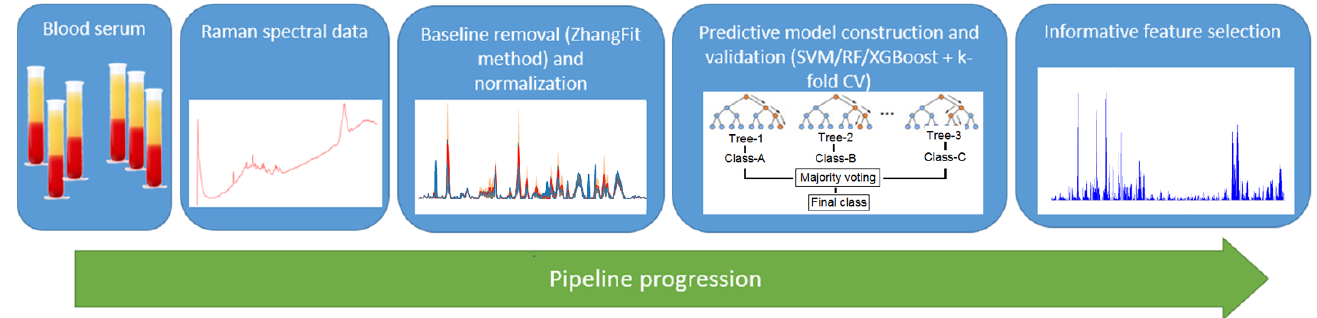
Figure 1. The implemented machine learning pipeline for Raman spectra analysis.